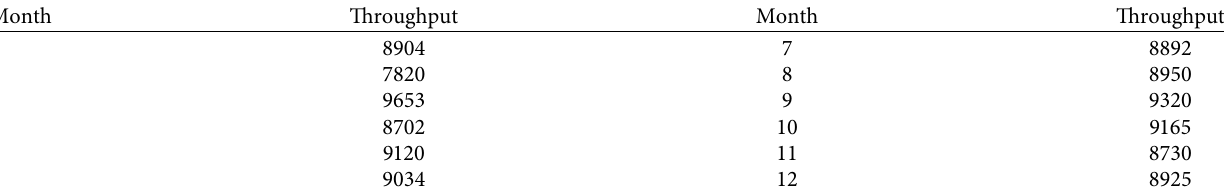
Table 1: Cargo throughput of a port in 2020/10 4 t.